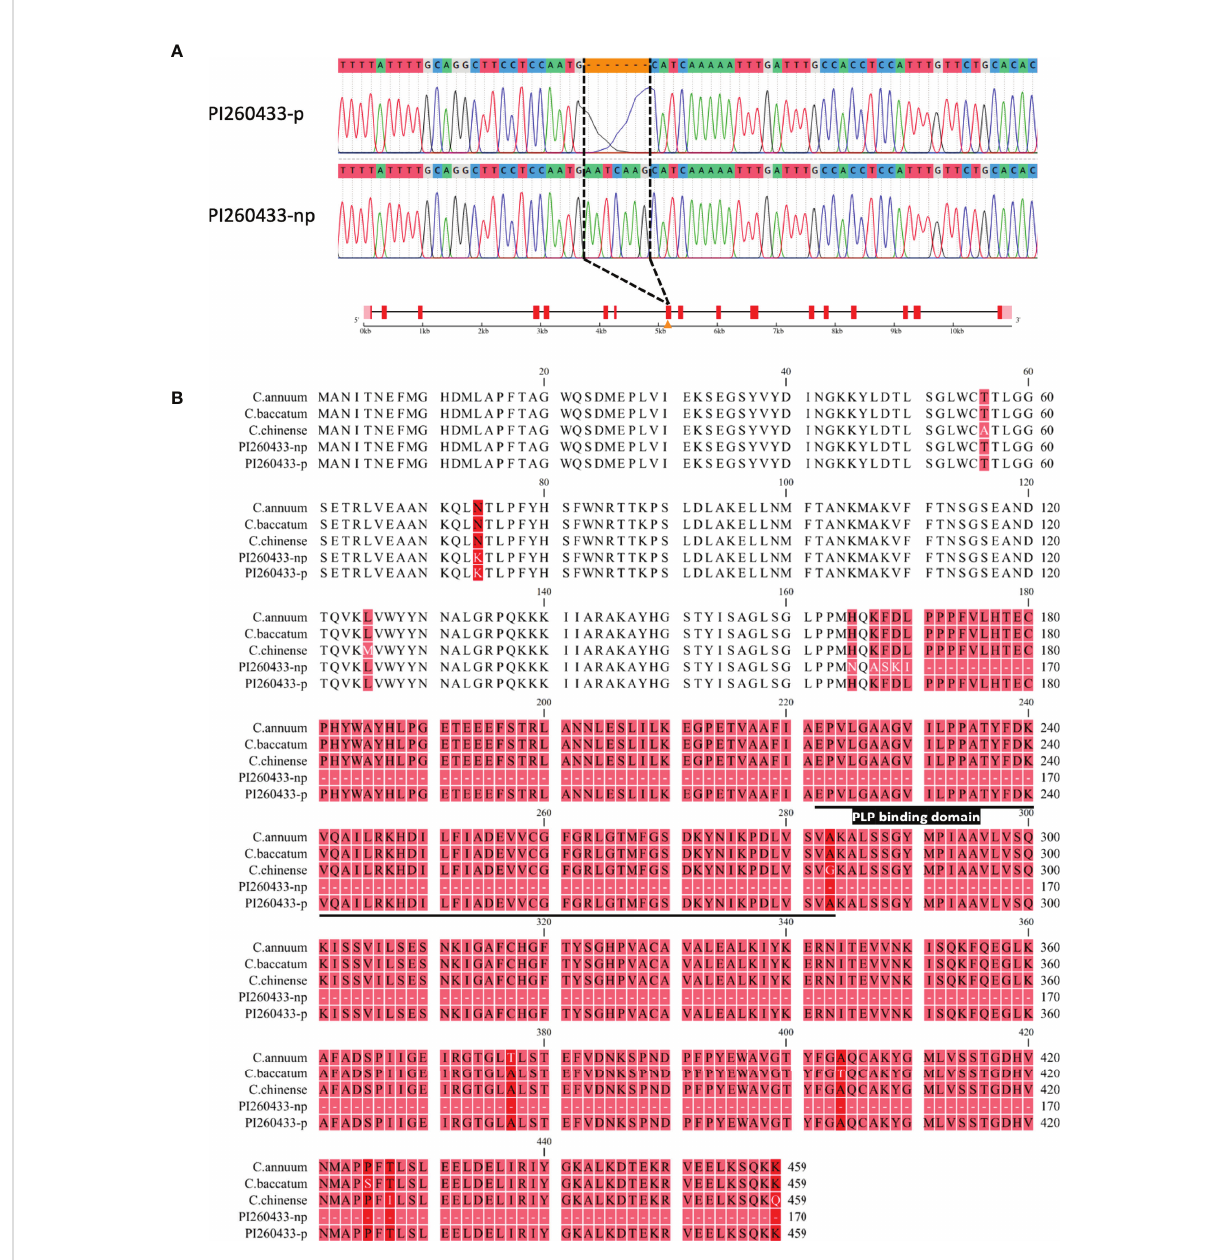
FIGURE 3 Schematic structure of pamt 11 . (A) Gene structure of pAMT . A sequence of 7 bp (5 ’ -AATCAAG-3 ’ ) is inserted in the 8 th exon of pAMT in PI260433-np. Boxes and lines indicate exons and introns, respectively. (B) Amino acid sequences of translated proteins of pAMT . The pyridoxal 5-phosphate (PLP) binding domain is underlined.